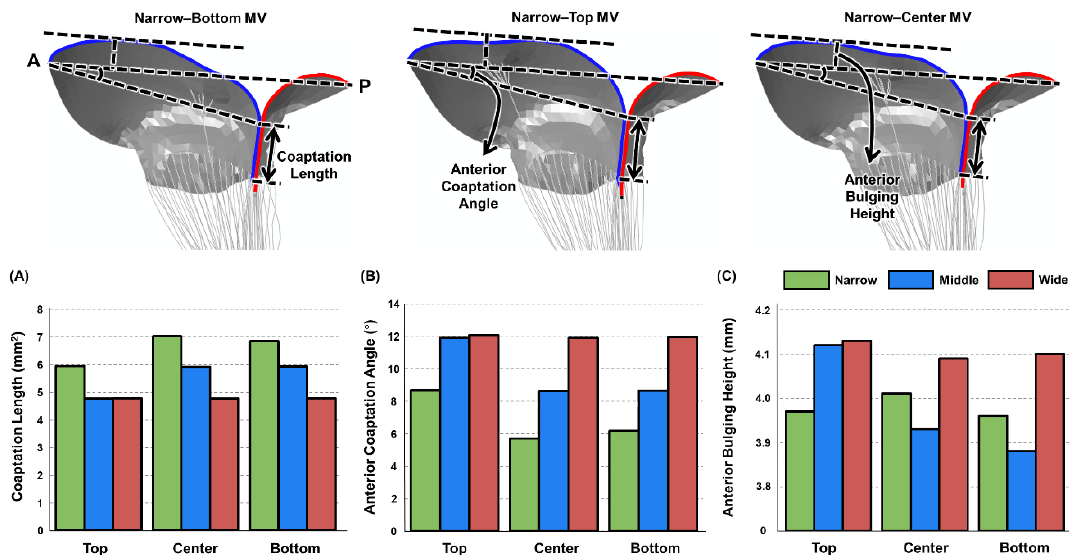
Figure 6. Morphologic features and quantitative assessment of the MV leaflets at peak systole. For the narrow MV group, the cross-sectional views of the A2-P2 leaflet edges are presented in blue (anterior leaflet) and red (posterior leaflet) lines. Quantitative morphologic assessment includes ( A ) coaptation lengths, ( B ) coaptation angles, and ( C ) anterior bulging heights. A — anterior; P — posterior.